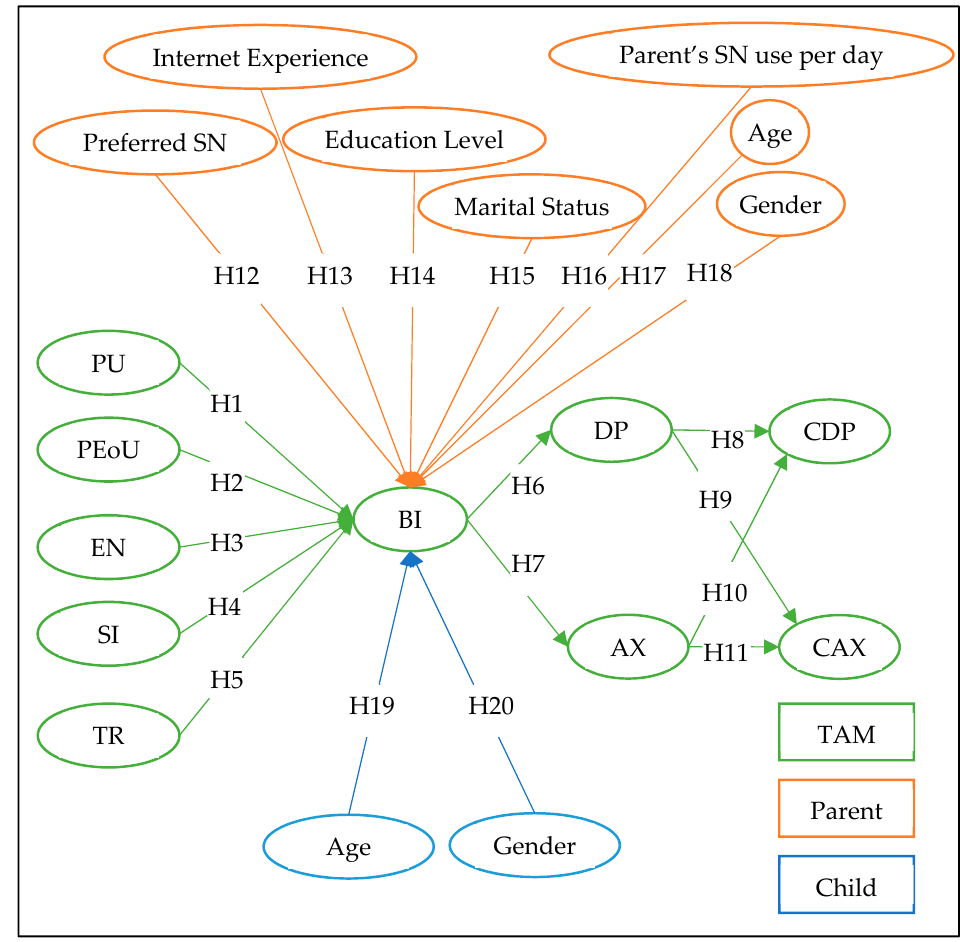
Figure 1. Proposed Model of the Research.